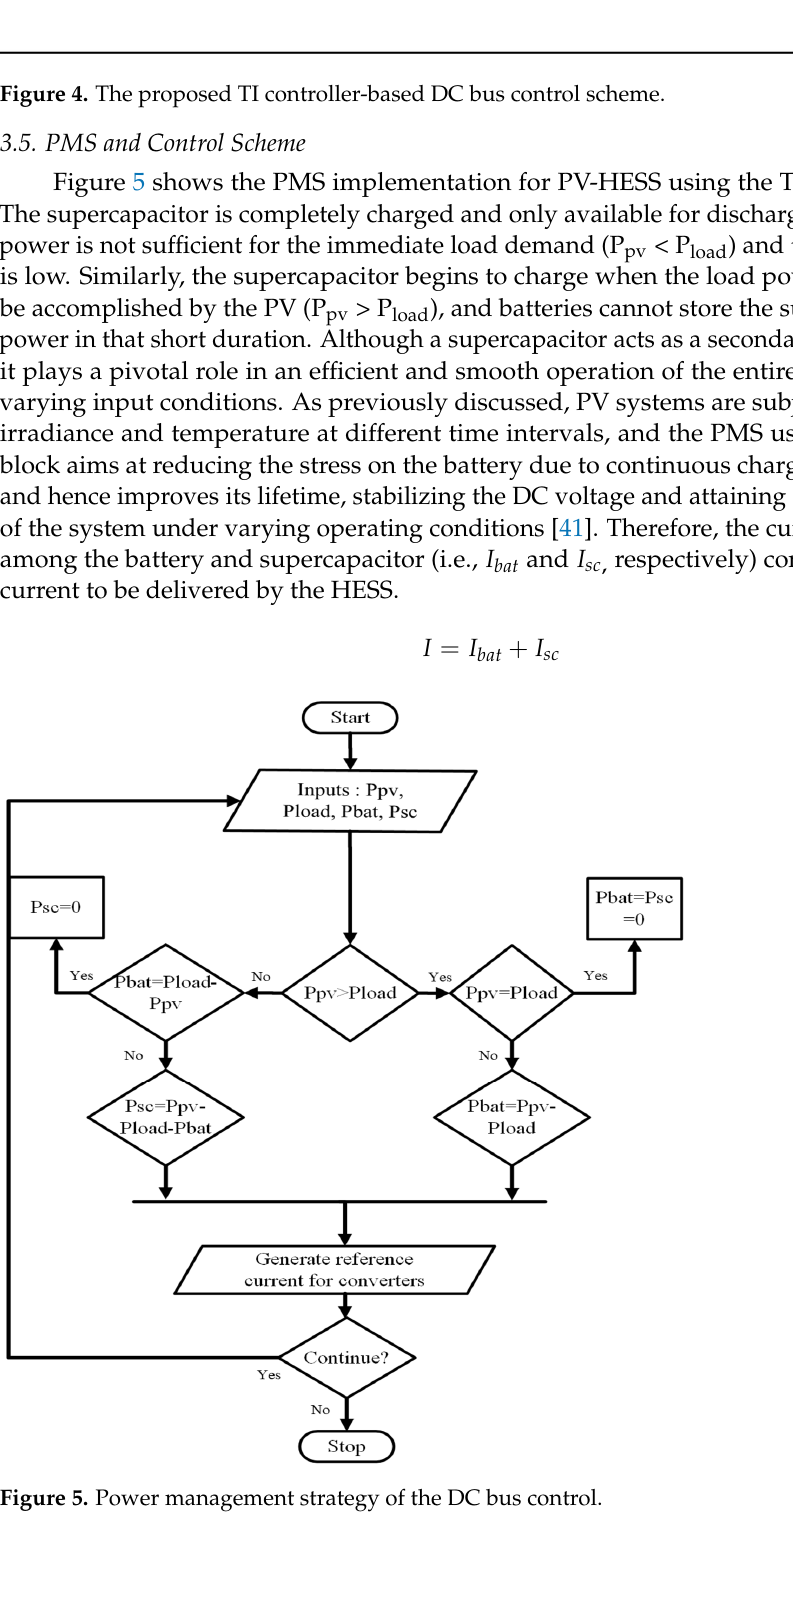
Figure 4. The proposed TI controller-based DC bus control scheme.